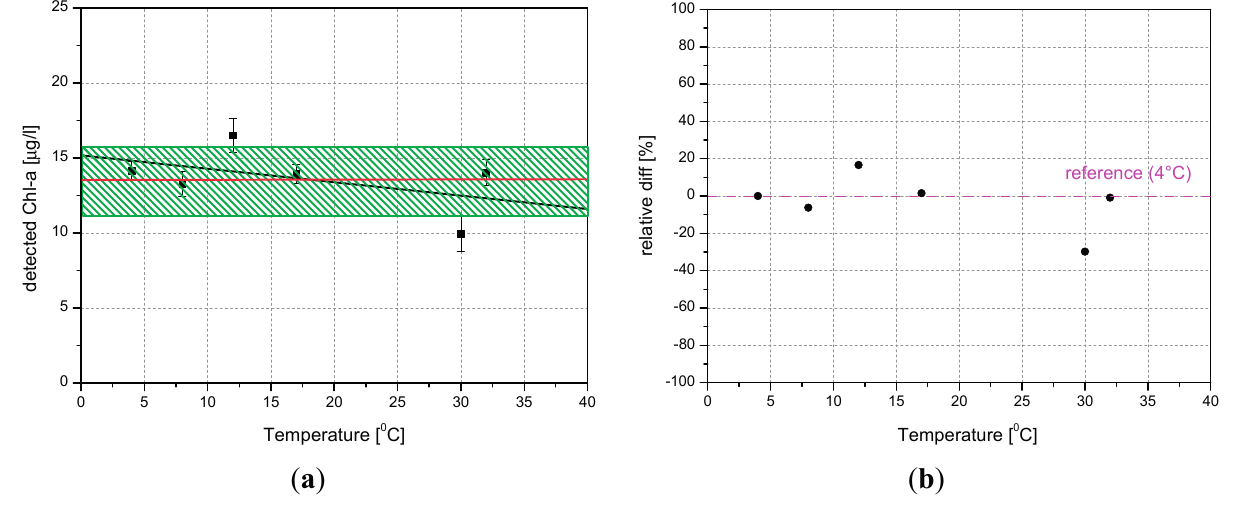
Figure 14. Effects of temperature on Chl-a detection ( a ); relative differences between the reference sample (4 °C) and samples of water containing a fixed amount of Chl-a at different temperatures ( b